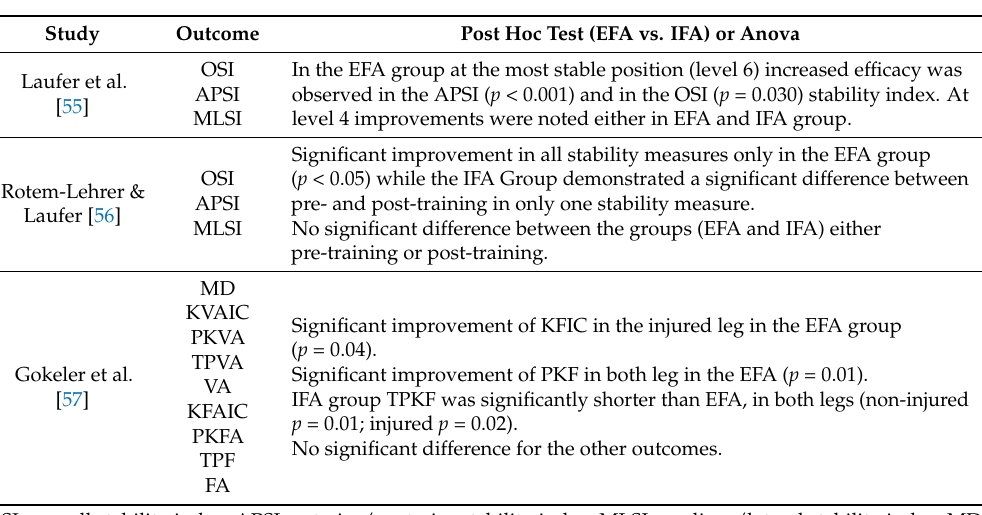
Table 4. Effects of attentional focus instructions on MSK